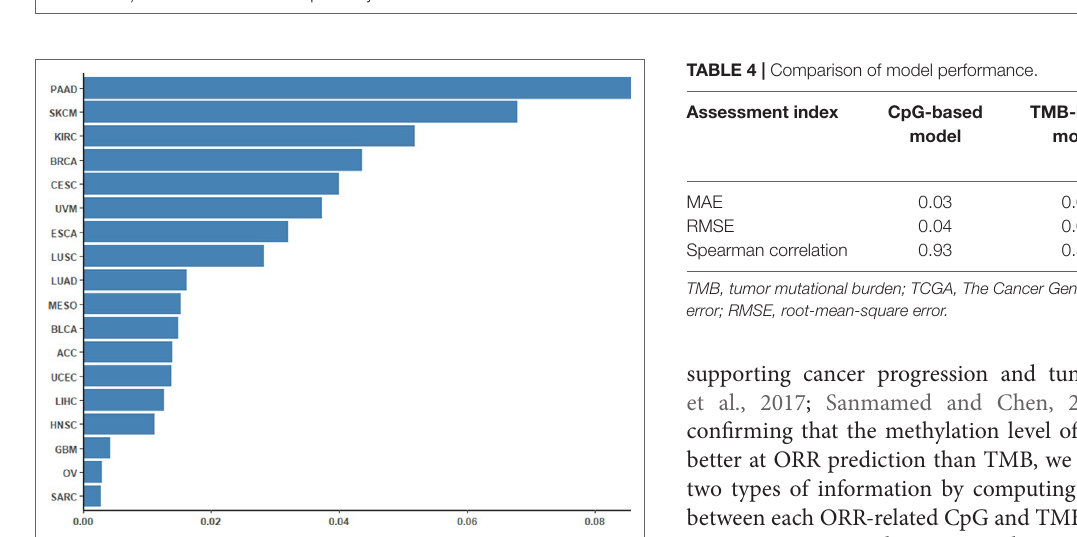
FIGURE 1 | Enriched immunological pathway and genes. The words in wine represent the Kyoto Encylopedia of Genes and Genomes (KEGG) pathway, and the purple circles represent objective response rate (ORR)-associated genes enriched in the KEGG pathway. The HLA class I antigens (HLA-B, HLA-C, HLA-E, HLA-G, and HLA-F) are related to all these pathways.